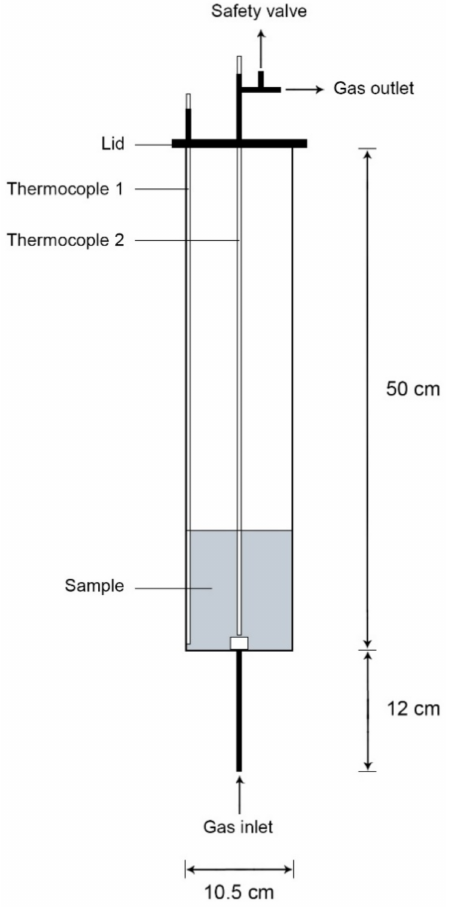
Figure 1. Side view of steel crucible, in accordance with